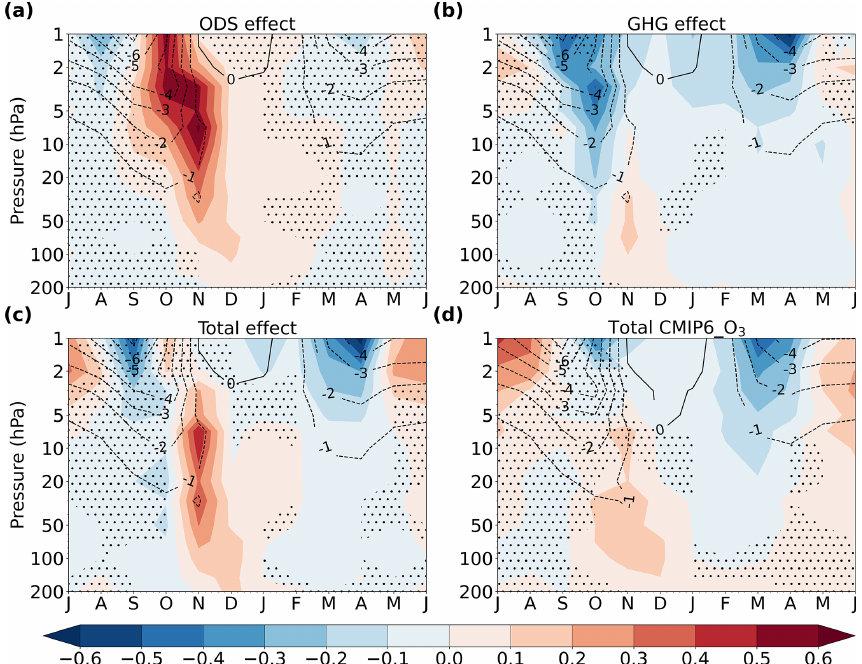
Figure 11. Changes in the polar cap (70–90 ◦ S) vertical residual velocity (in mms − 1 ) for each month and pressure level (color shading): effect of ozone recovery (a) , effect of GHGs (b) , total effect in INTERACT_O 3 (c) , and total effect in CMIP6_O 3 (d) . The contours depict the current-day (2011–2030) climatology from INTERACT_O 3 in (a) – (c) and from CMIP6_O 3 in (d) . The stippling masks regions where the changes are not significant at the 95% confidence interval based on a two-tailed t